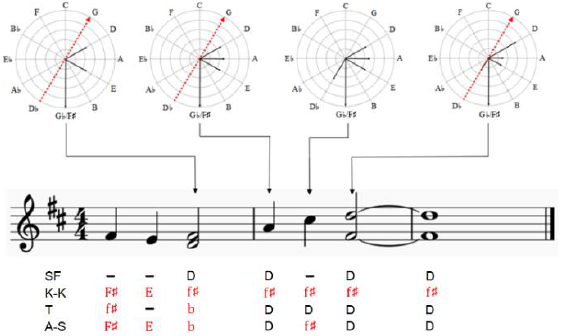
Figure 6. The results of the music key detection obtained for the method implementing the signature of fifths (SF) as well as for the strictly correlational approaches based on the music key-profiles of Krumhansl–Kessler (K-K), Temperley (T), and Albrecht–Shanahan (A-S), observed for the successively increased lengths of an analyzed music fragment—the weighting of individual pitch-classes was realized with the multiplicities of their occurrences (incorrectly detected keys are marked in red).